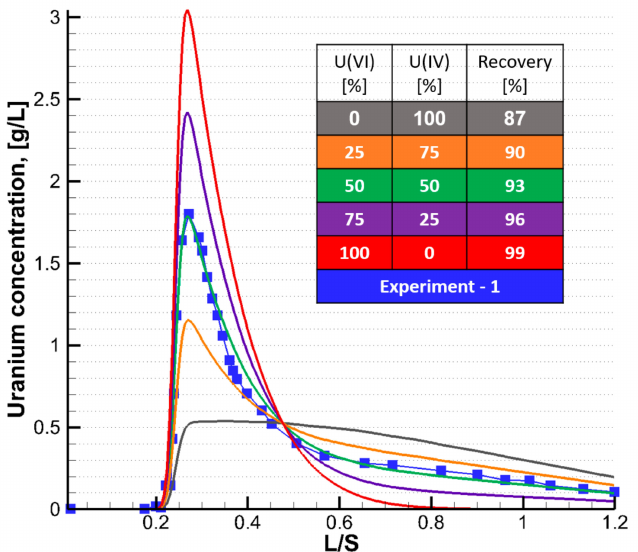
Figure 11. Uranium concentration at the outlet tube for different ratios between U (IV) and U (VI) against the dimensionless L/S for the reaction rate value estimated in Section